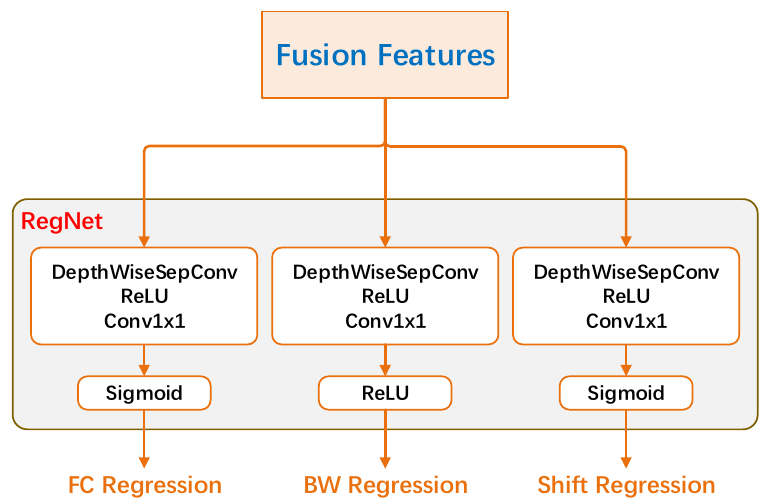
Figure 4. The RegNet head in the FFSCN model.